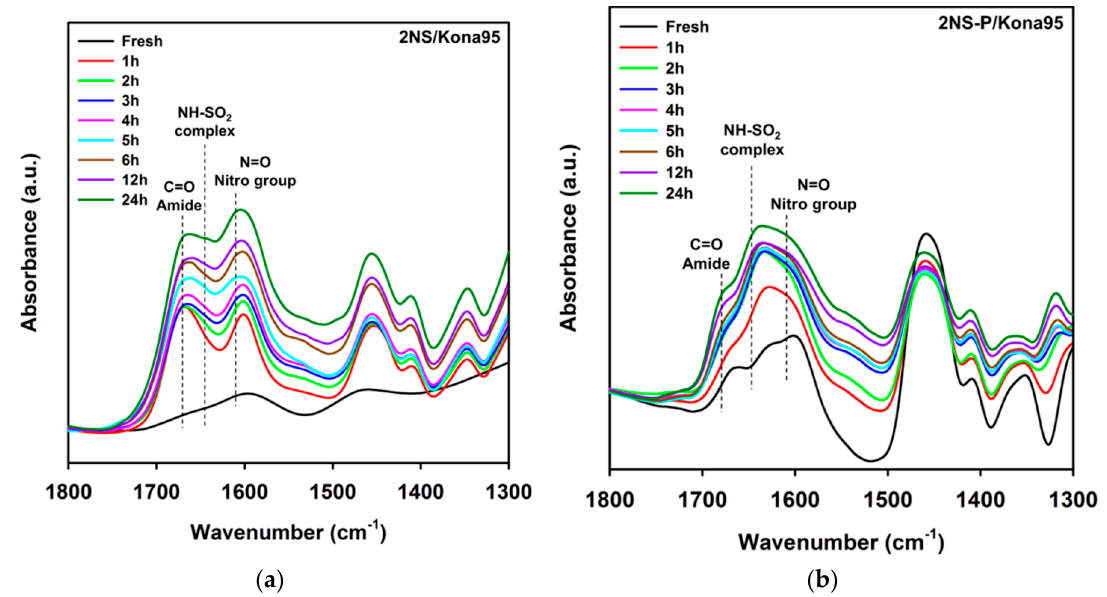
Figure 7. Changes in the in situ FT-IR spectra of ( a ) 2NS/Kona95 and ( b ) 2NS-P/Kona95 exposed to 50 ppm SO 2 at 110 °C.